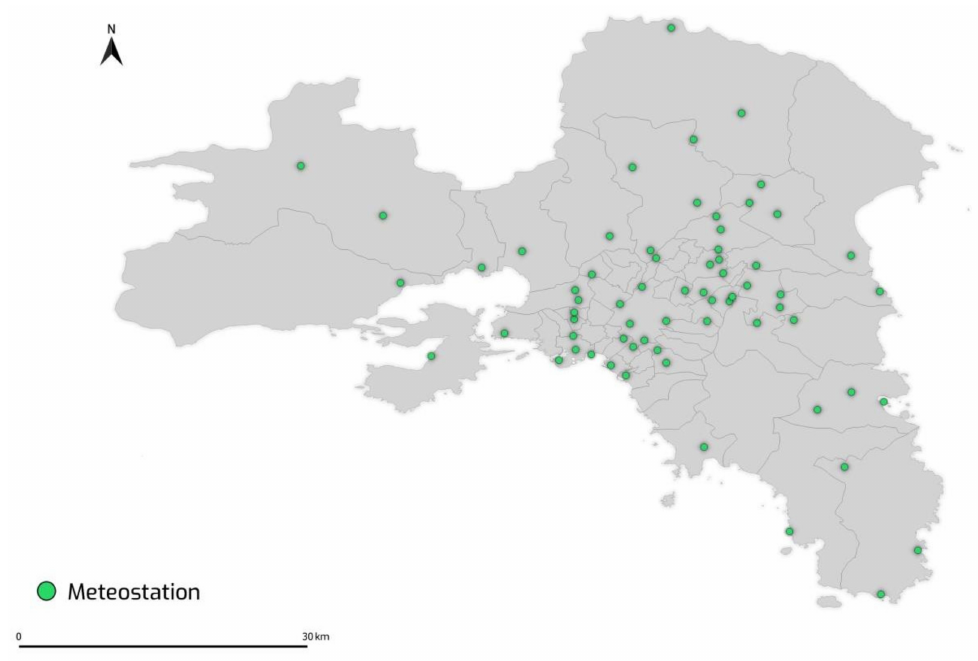
Figure 1. Location of the meteorological stations in the Athens Metropolitan Area (AMA), highlight- ing the postal code (PC)